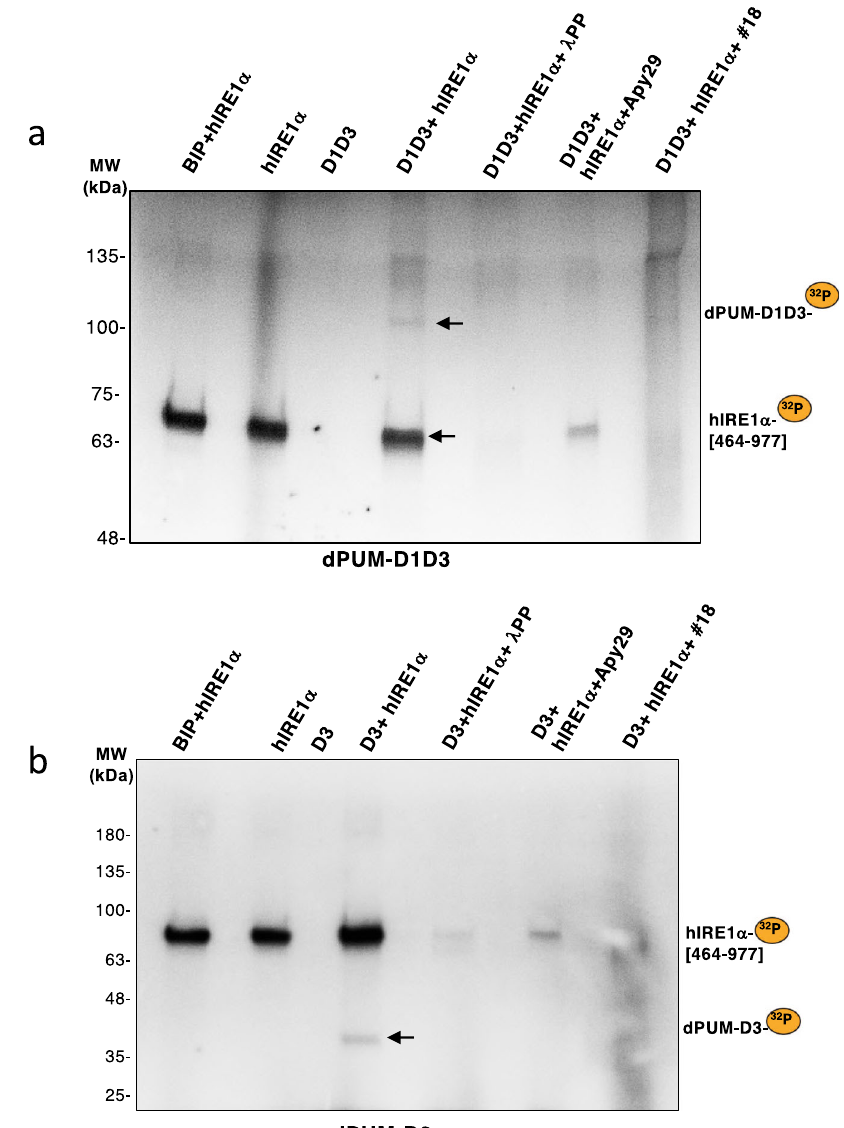
Fig. 4 hIRE1 α KR phosphorylates Pumilio in vitro. In vitro radioactive phosphorylation assays of puri fi ed Pumilio dPUM-D1D3 ( a ) and dPUM-D3 ( b ) with hIRE1 α KR (464-977). Puri fi ed proteins were incubated 2h in IRE1 kinase buffer containing γ -ATP[ 32 P]. Detection of radioactive dPUM-D1D3, dPUM-D3 and auto-phosphorylation of hIRE1 α KR are denoted by a yellow bullet 32 P. Negative controls: BIP as a luminal ER protein non-phosphorylated by IRE1, and proteins without incubation with hIRE1 α KR. Speci fi city of phosphorylation was monitored by treatment with λ -phosphatase ( λ PP) or incubation with speci fi c inhibitors of IRE1 kinase activity (Apy29 and compound #18). MW: protein molecular weights in kDa. n = 3 of independent experiments. Source data fi le is